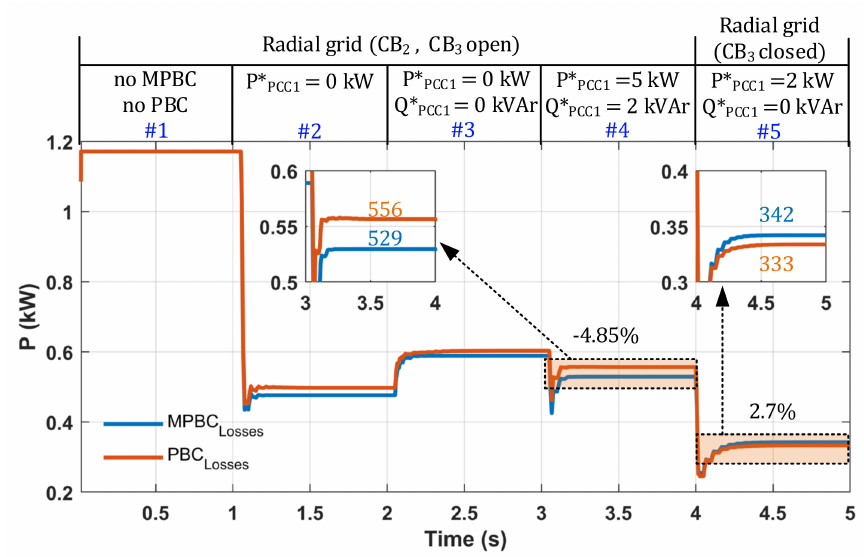
Figure 6. Power loss in the µ G with MPBC and